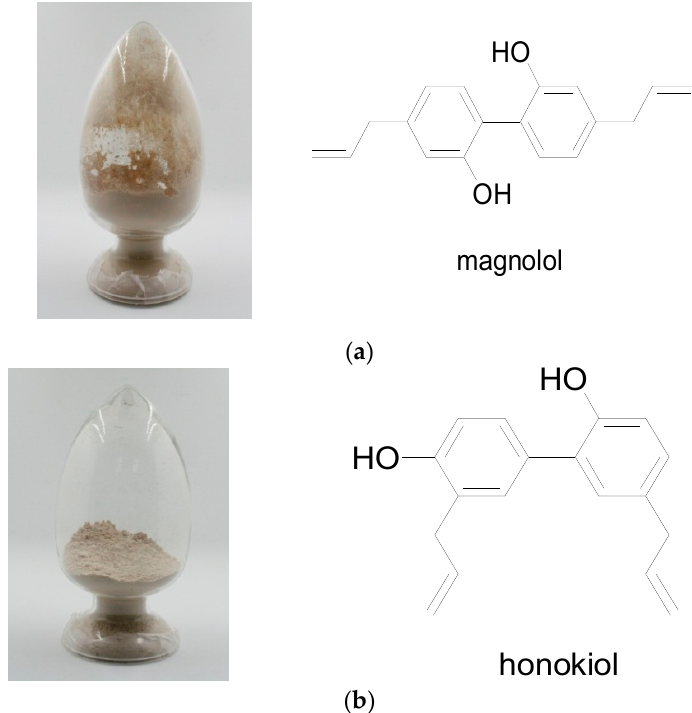
Figure 2. Sample and structure of the compound identified as magnolol and honokiol. ( a ) Magnolol; ( b ) honokiol.